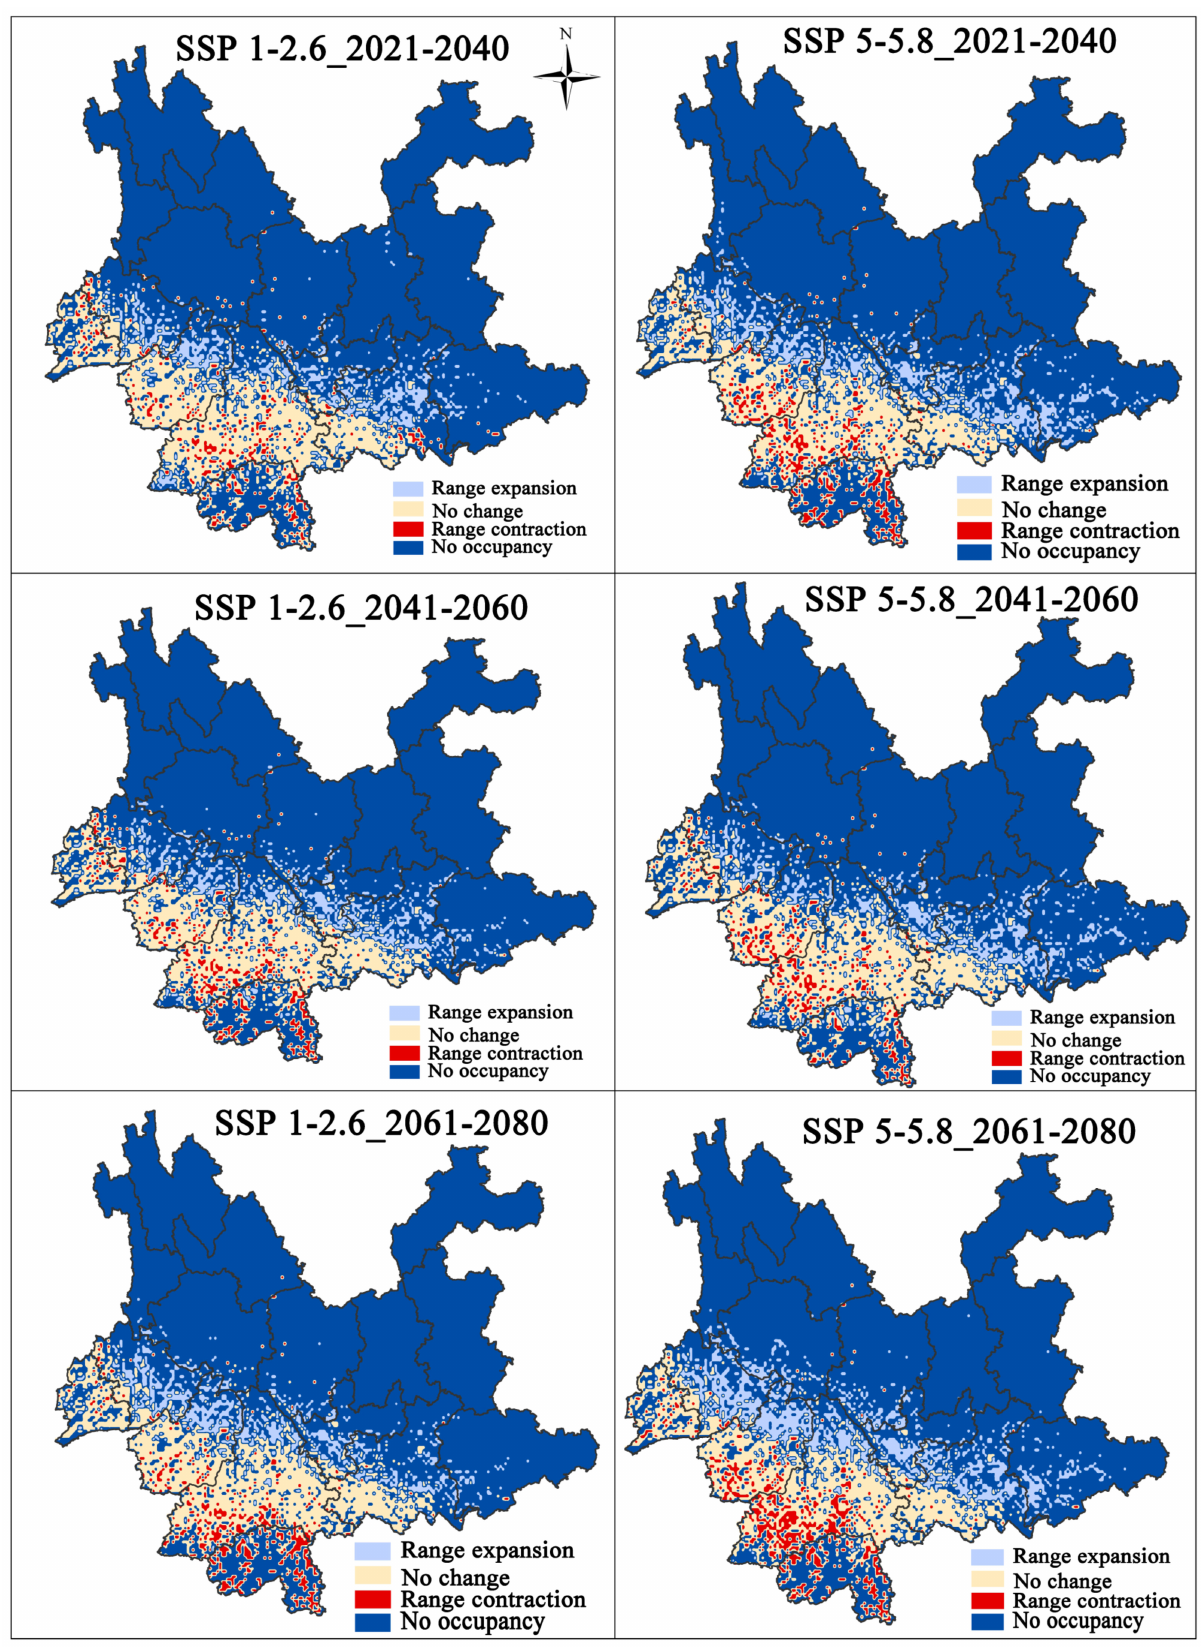
Figure 6. Distribution of potential suitable change for F. strictus under future climate change. The change of the suitable area compared to the